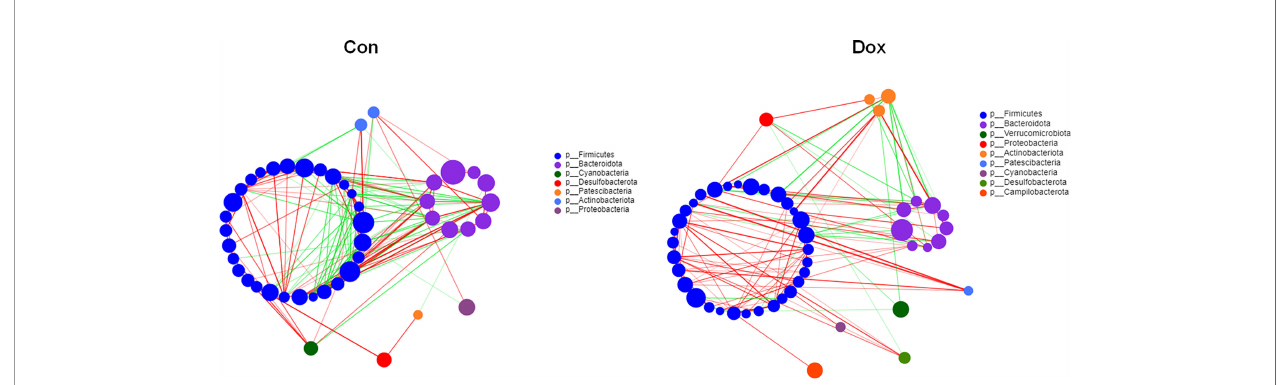
FIGURE 4 | Correlation network analysis of the 50 most abundant genera for each group. The size of the node indicates the genera abundance, and different colors indicate different phyla. The lines indicate signi fi cant positive (red) and negative (green) pairwise correlations, and the thickness indicates the strength of the correlation between two genera. Spearman ’ s value ≥ 0.05, p < 0.05. Con, control; Dox, doxorubicin. n